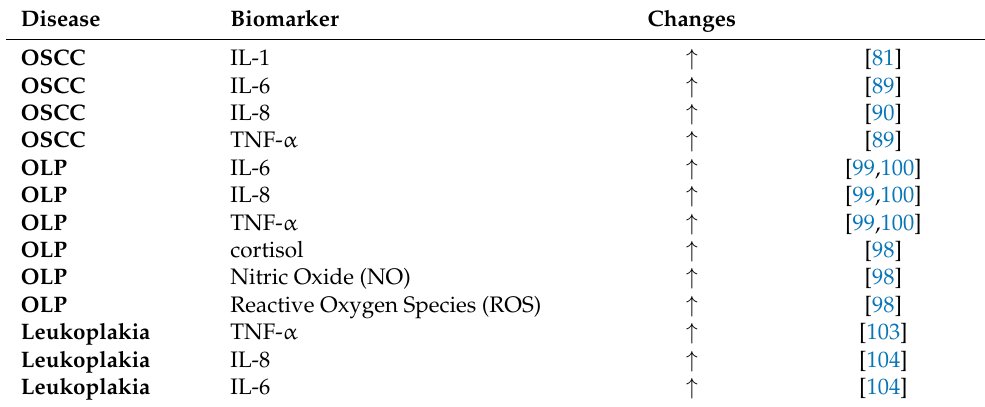
Table 2. Change in concentration in saliva of biomarkers of OSCC, OLP and Leukoplakia. Disease